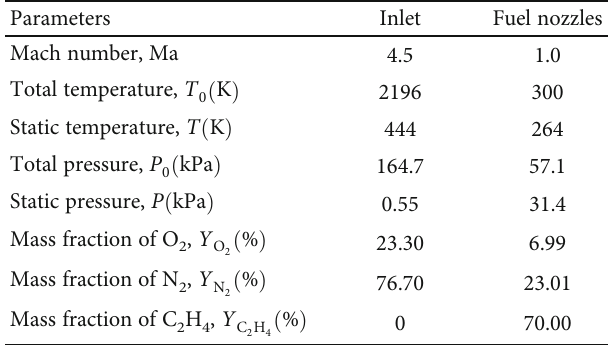
Table 1: Inlet and fuel nozzle boundary conditions